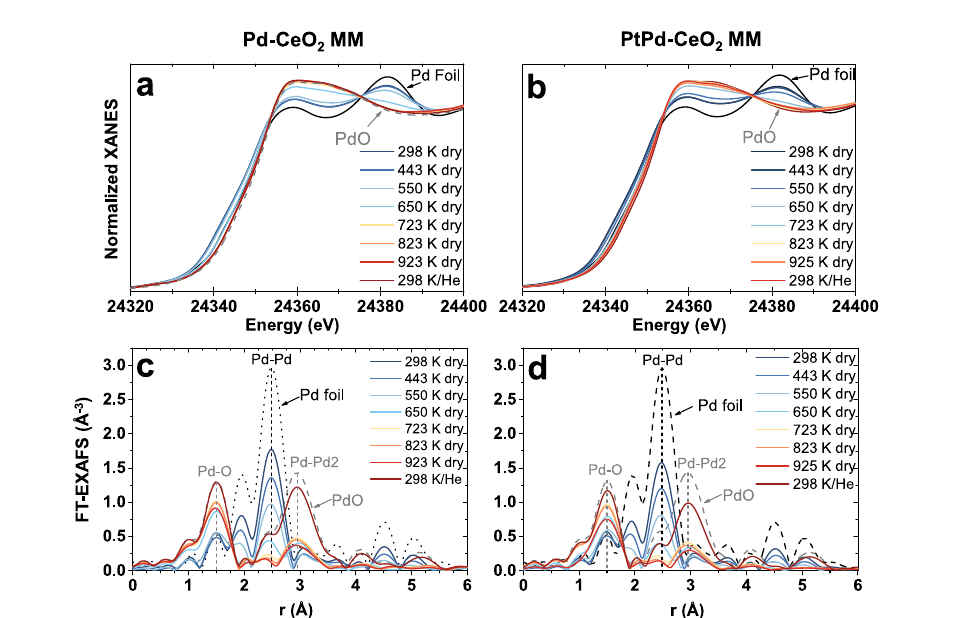
Fig. 3 | Series of in situ Pd K-edge data recorded under dry methane combus- tion conditions at increasing temperatures. a , b XANES spectra of Pd-CeO 2 MM and PtPd-CeO 2 MM, respectively. c , d Magnitudeof the FT of the EXAFS spectraof